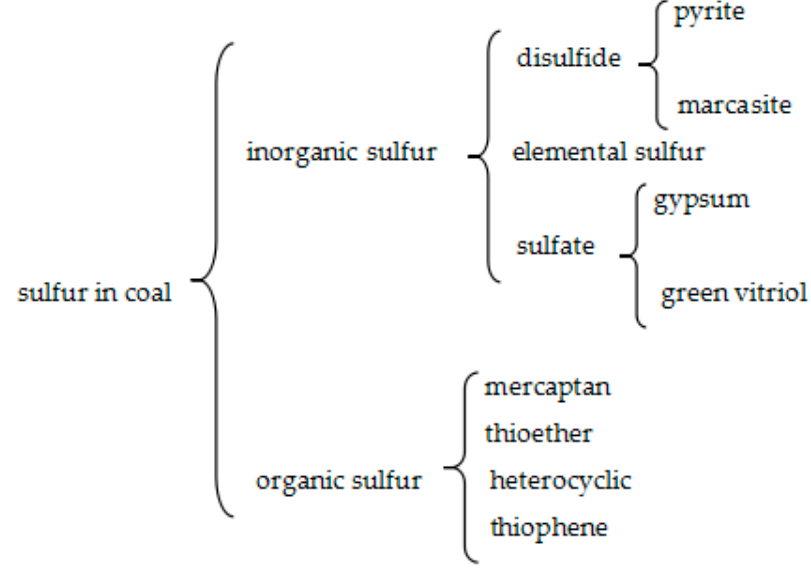
Figure 1. Distribution of sulfur in coal.